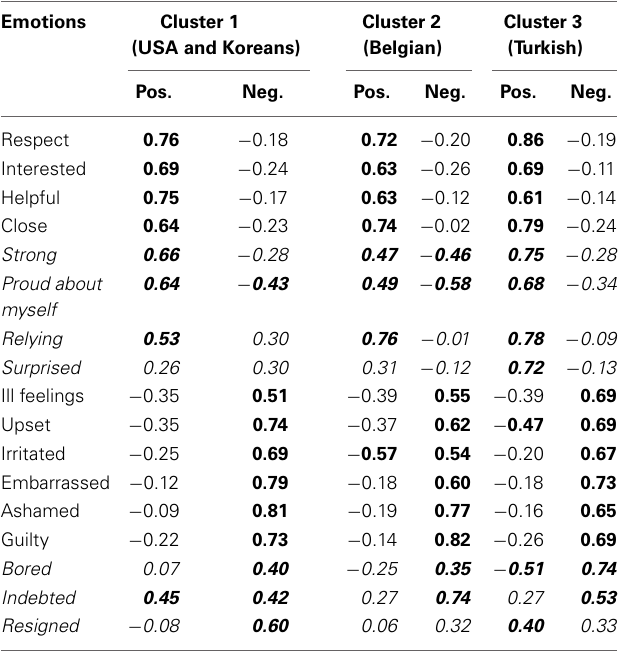
Table 3 | Cluster-specific loadings for the clusterwise SCA-P model with three clusters and two components per cluster, orthogonally Procrustes rotated toward a positive and negative target structure.